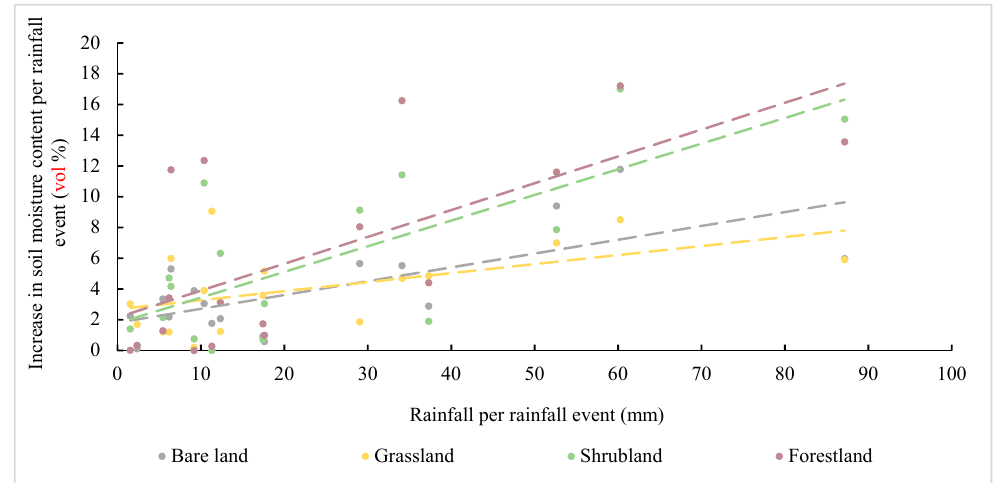
Figure 7. Correlation between increasing volumetric soil moisture content and rainfall. Table 8. Significance level of Spearman correlation and regression analysis between increases in volumetric soil moisture content and the amount of rainfall per precipitation event.